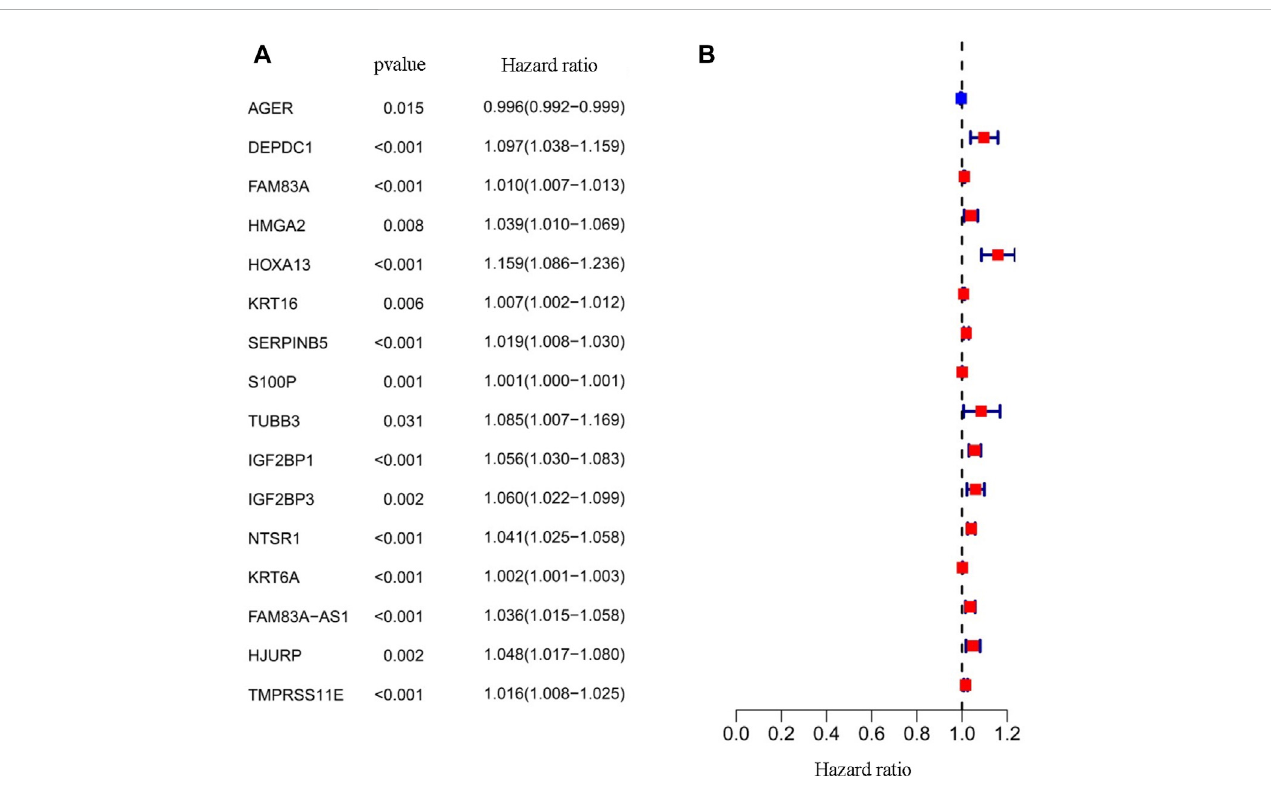
FIGURE 2 PrognosticvalueoftheEMT-LUADrelatedgenes. (A) TheUnivariateCoxanalysisidenti fi ed16genes,includingAGER,DEPD1,FAM83A,HMGA2,HOXA13, KRT16, SERPINB5, S100P, TUBB3, IGFBP1, IGFBP3, NTSR1, KRT6A, FAM83A-AS1, HJURP, and TMPRSS11E. (B) The forest map showing the hazard ratio of the sixteen EMT-LUAD related genes.